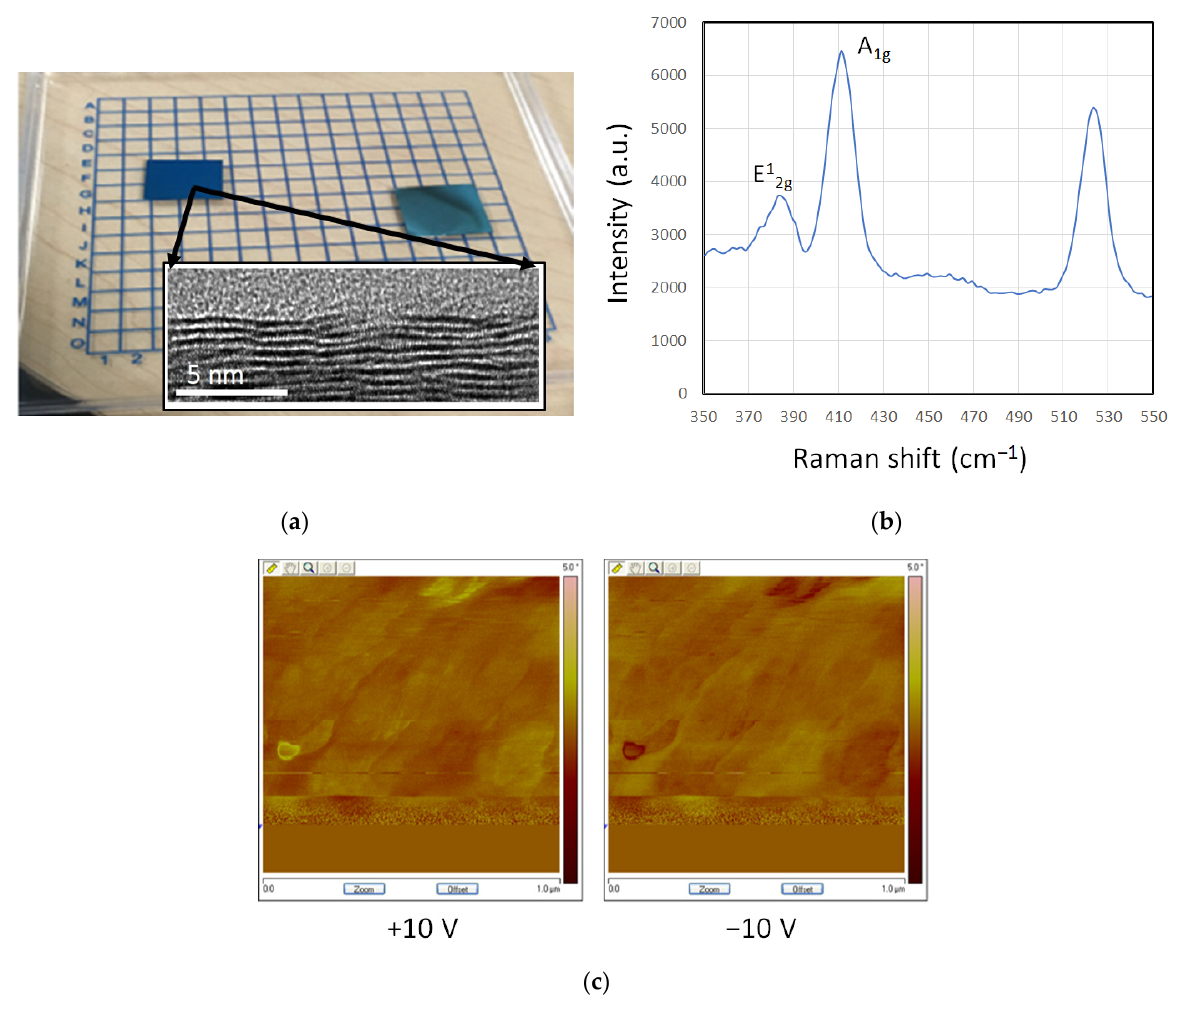
Figure 1. Schematic of the smart charging system proposed for EVs and roadway infrastructure.